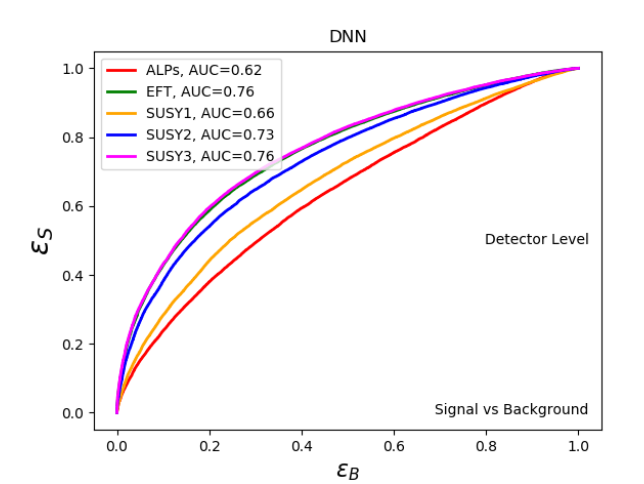
Figure A5: Neural Network dijet detector-level ROC curves for different signals ver- sus background.